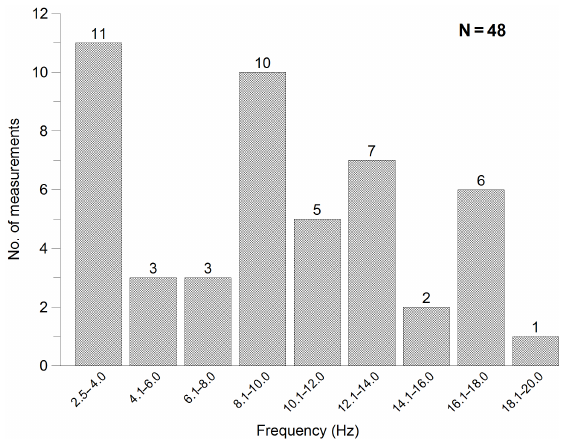
Figure 7. Distribution of sediments main frequency derived from microtremor HVSR analysis at 48 points with sufficient